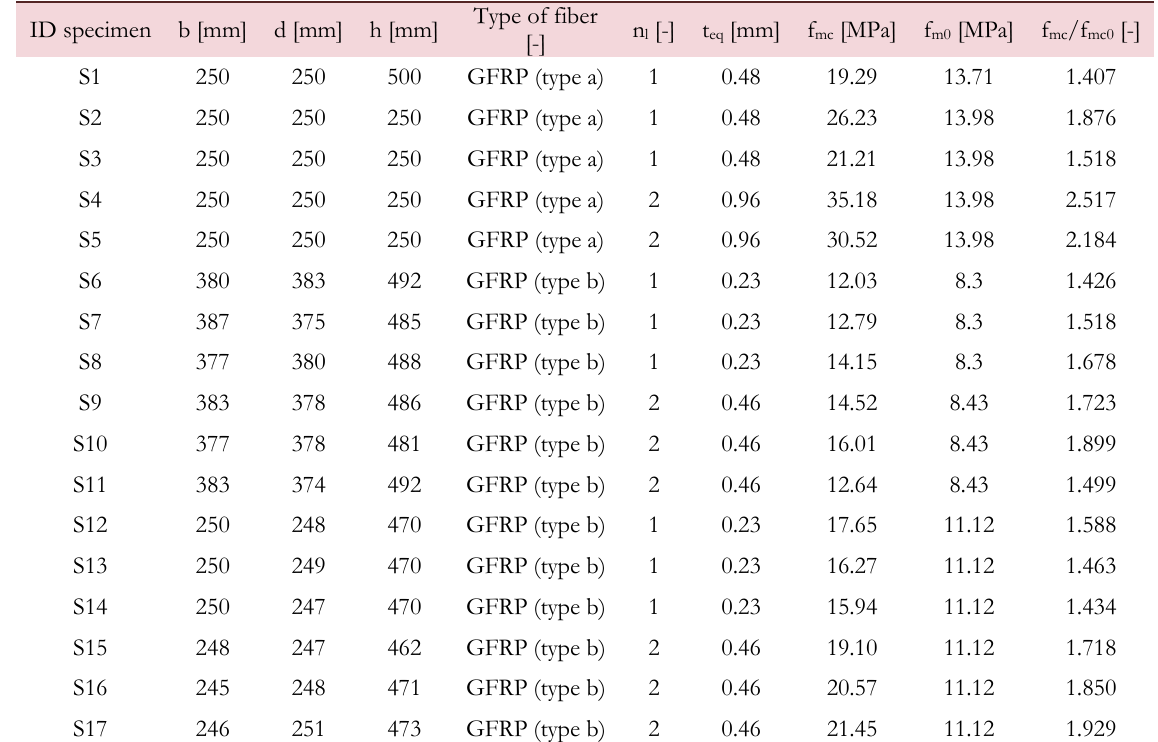
Table 1.B: Geometrical characteristics and experimental results [33].